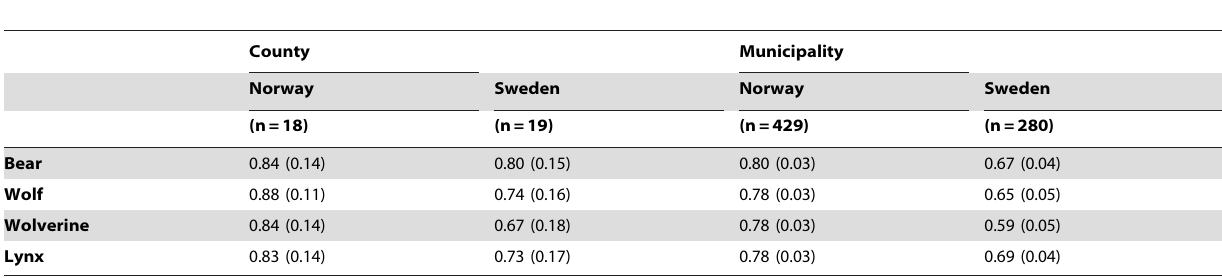
Table 2. Spearman correlation coefficients (r sp 6 SE r ) between mean acceptance level of poaching and PCI 2 at the county and municipality level in Norway and in Sweden (all p , 0.001).